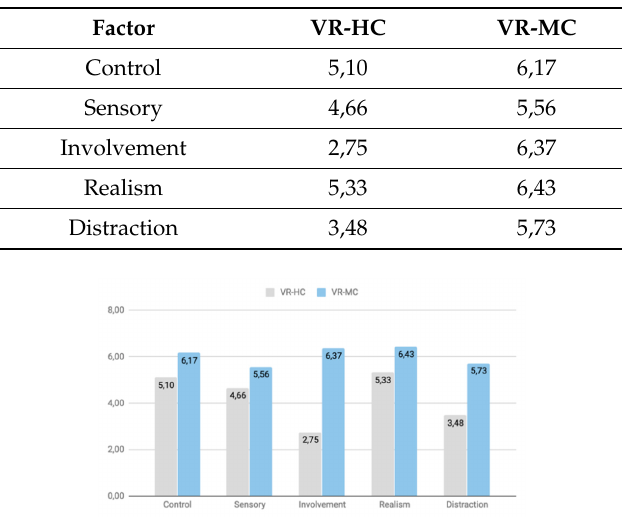
Table 3. Comparison of the mean of the Control, Sensory, Involvement, Realism, and Distraction Factors between the VR-HC and VR-MC systems.